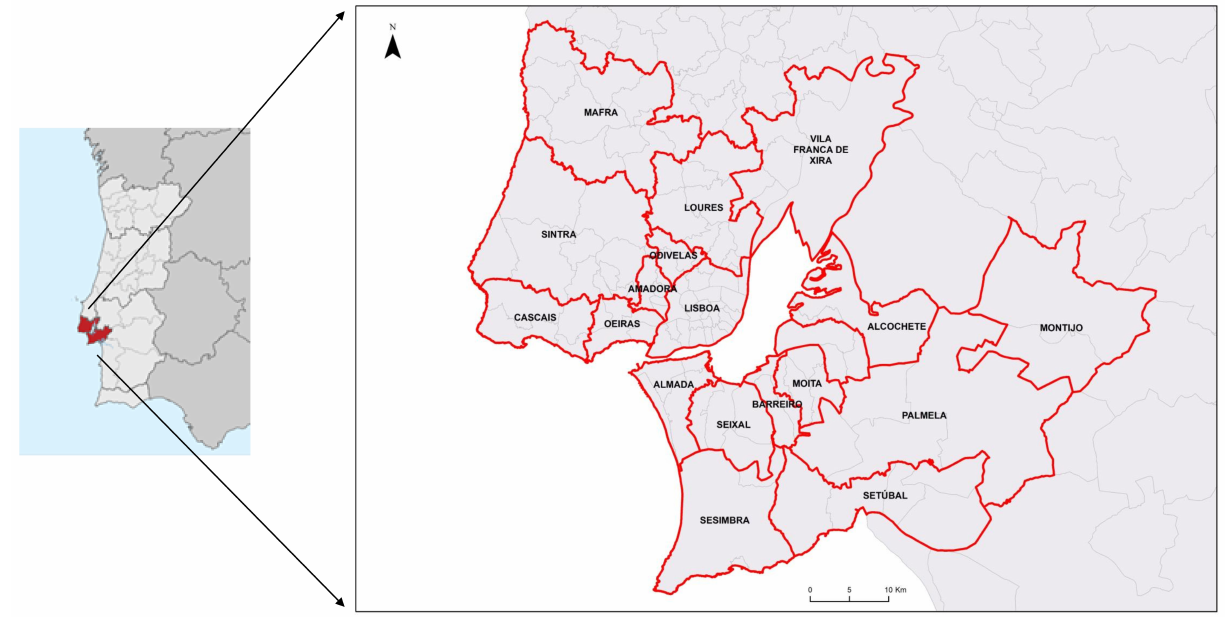
Figure 1. The LMA location in Portugal and the administrative boundaries of its 18